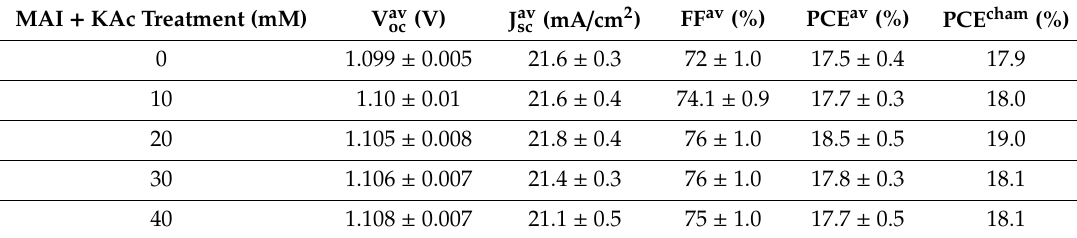
Table 4. PSCs’ photovoltaic parameters of the MAPbI 3 PSCs with a combination of MAI + KAc treatment. The J sc , V oc , FF, and PCE average values were measured in backward scanning mode. PCEs for the champion PSCs are also reported.